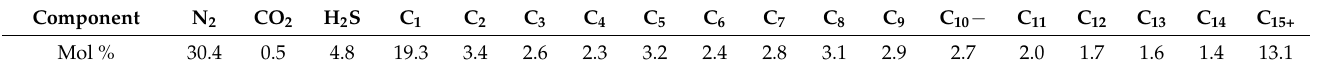
Table 1. Composition of reservoir (live) oil.